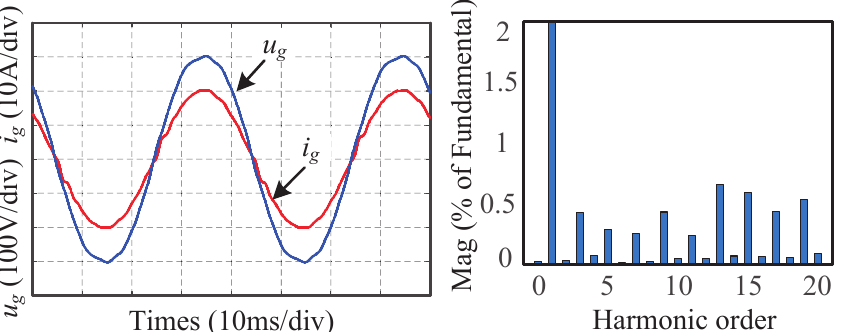
Figure 18. Output waveforms of the PIMR-RC system and spectrum analysis of the output current when f g = 50.4 Hz.